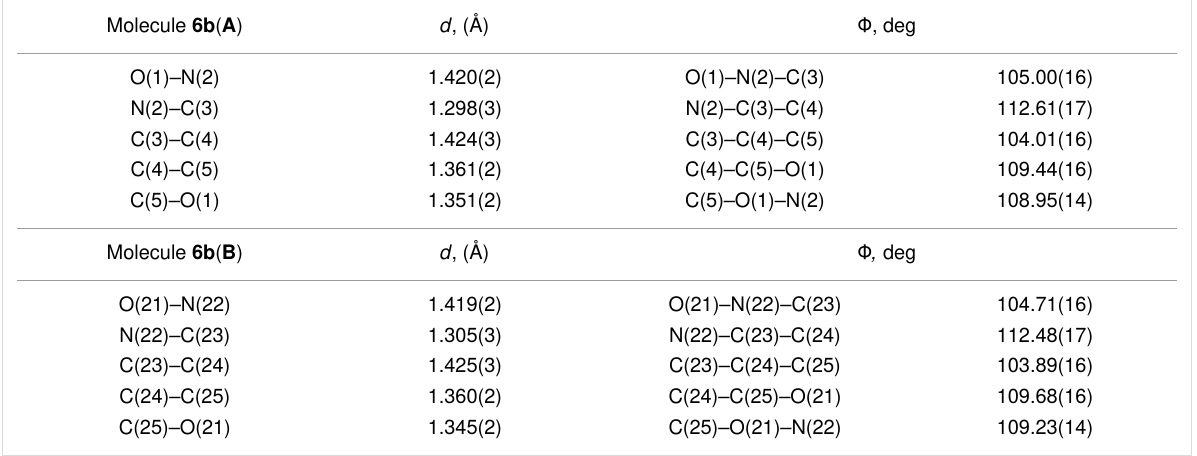
Table 1: Bond lengths and angles of 1,2-oxazole fragments in an asymmetric unit of 6b .